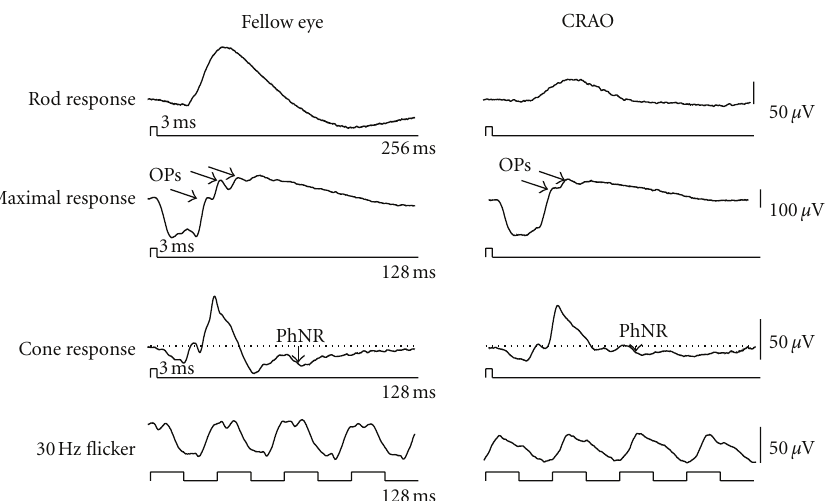
Figure 10: Representative waveforms of the full-field electroretinogram recorded from una ff ected fellow and a ff ected eyes with central retinal artery occlusion (CRAO). OPs: oscillatory potentials, PhNR: photopic negative response.